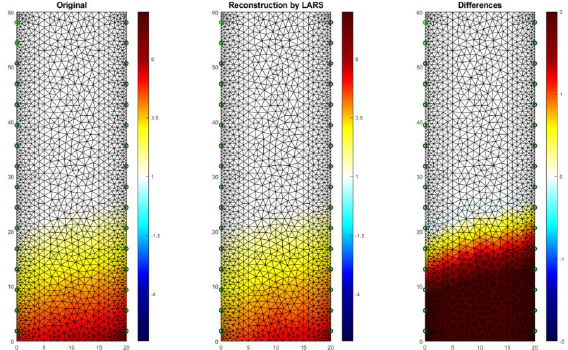
block for the case of 2 × 16 electrodes.